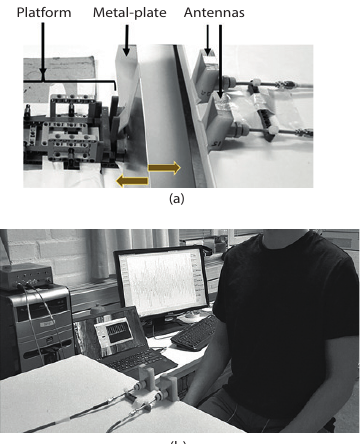
Figure 4. Measurement scenarios for ( a ) the robot movement detection and ( b ) the detection of human vital signs.